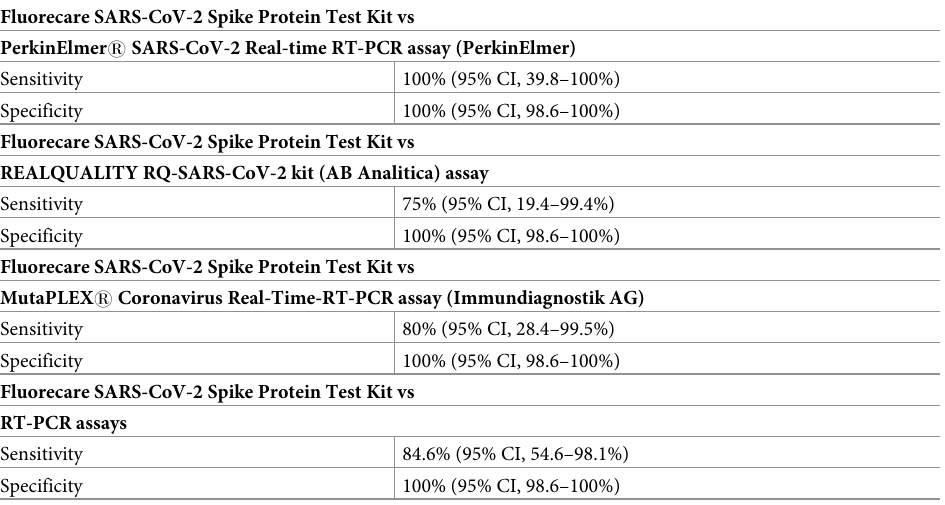
Table 3. Clinical performance of Fluorecare SARS-CoV-2 Spike Protein Test Kit according to RT-PCR assays. Fluorecare SARS-CoV-2 Spike Protein Test Kit